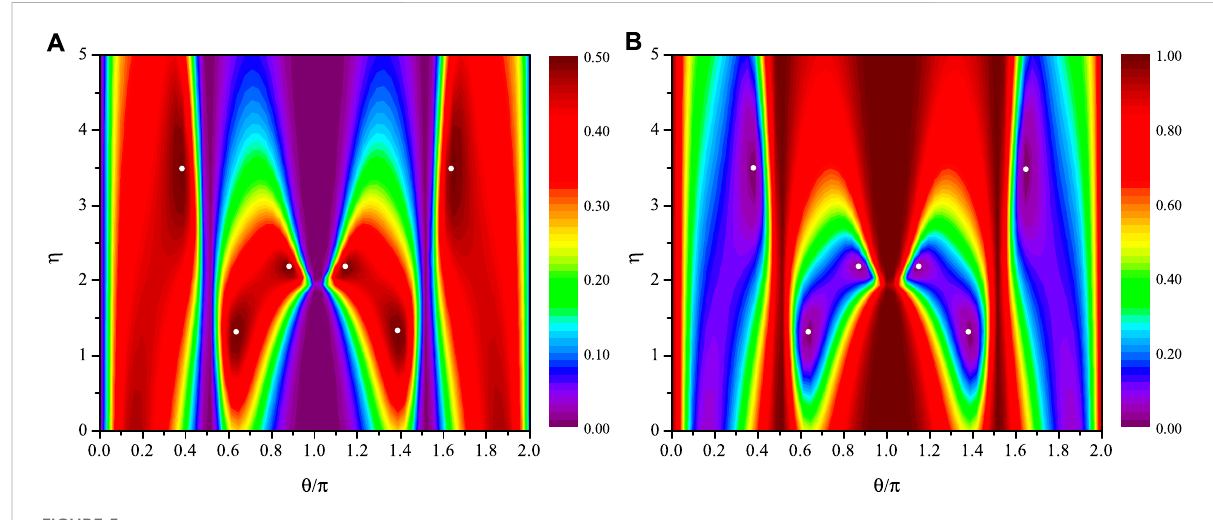
FIGURE 5 Theextremevaluesof T n (A) and R m (B) forvariousphaseshift θ andtheratio η betweenthetwoatom-waveguidecouplingstrengths.Whitedots represent extremum points with T n = 0.5 or R m = 0, showing symmetric about θ = π . The values of theparameters atthe six extreme points are listed in Table 1. The interatomic interaction is fi xed to g = 0.